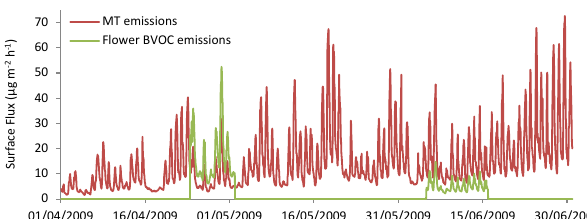
Fig. 12. Time series of modeled total floral and foliage BVOC emis- sions (blue) and default MEGAN, foliage monoterpene emissions only (red), during the honey locust flowering period for the City of Boulder urban